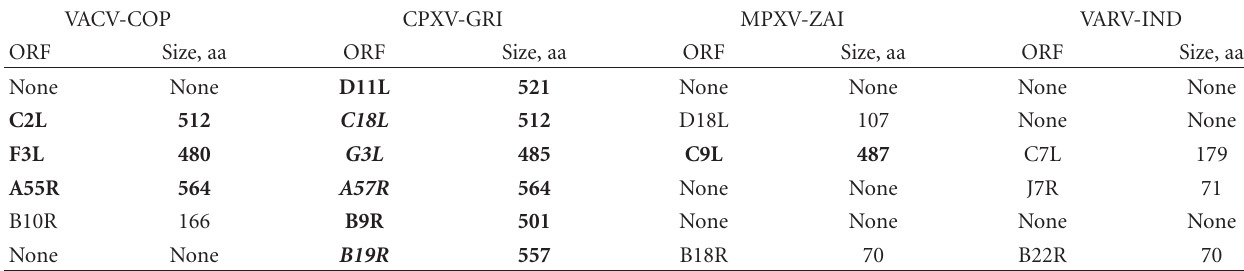
Table 3: Orthopoxviral BTB-kelch-like